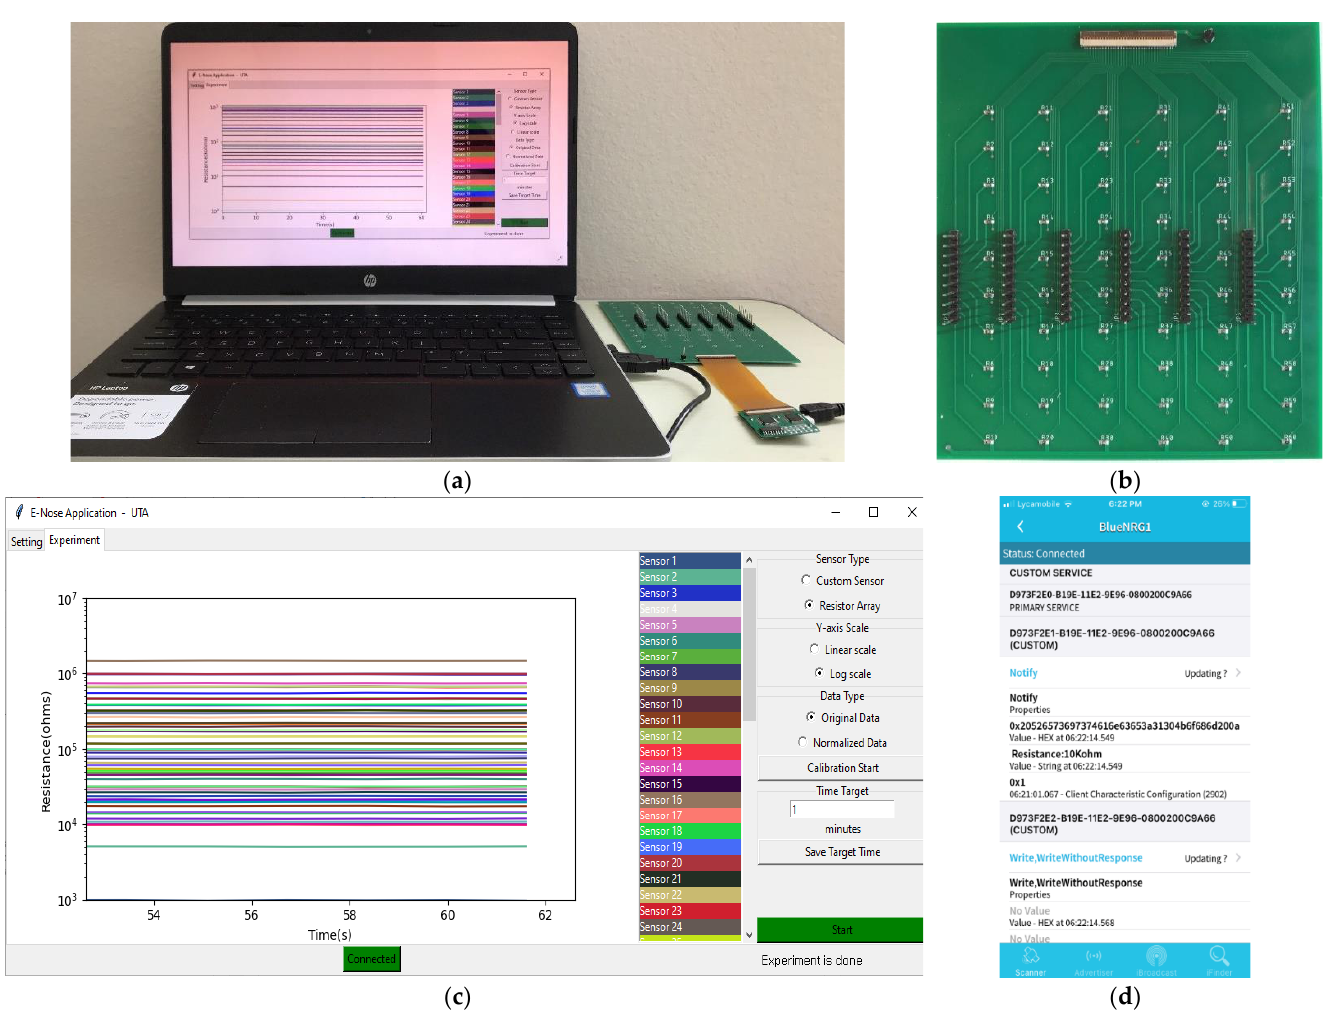
Figure 7. ( a ) Test setup with the readout board and the 60-resistor array; ( b ) 60-resistor array; ( c ) 60 resistor results displayed in the GUI; ( d ) system response displayed in a smartphone. To validate the error rate of the proposed system, Equations (3)–(5) were